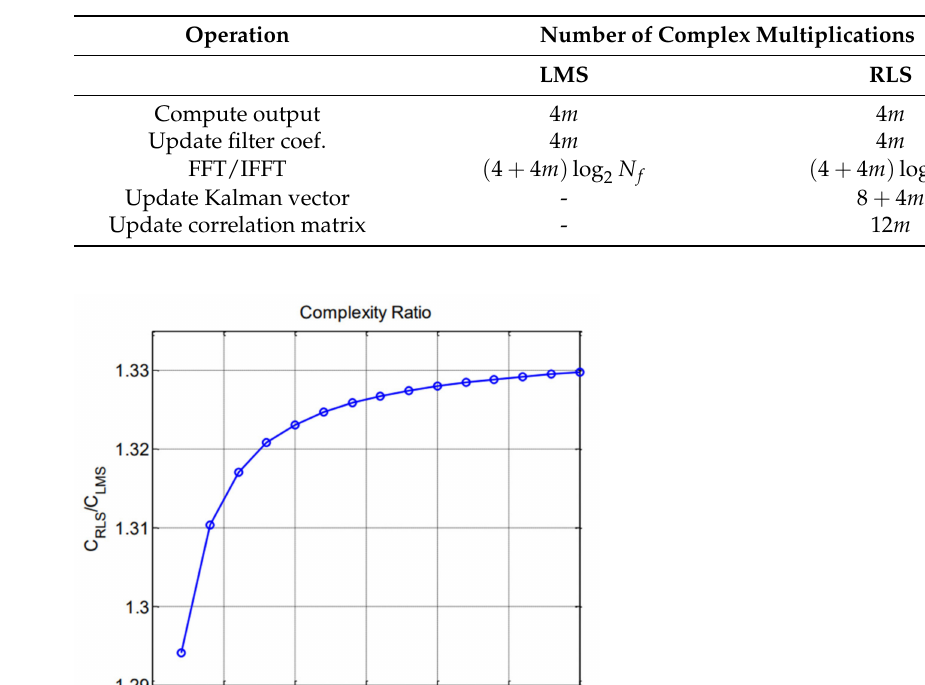
Table 1. Complexity comparison between the FD-RLS and FD-LMS.